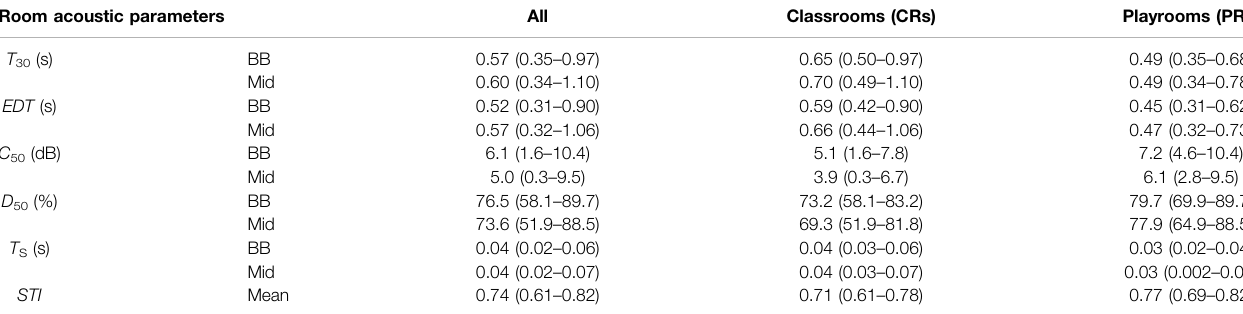
TABLE 4 | Summary of room acoustic parameters in Table 3 . Reported values are mean and the range (in brackets). Room acoustic parameters